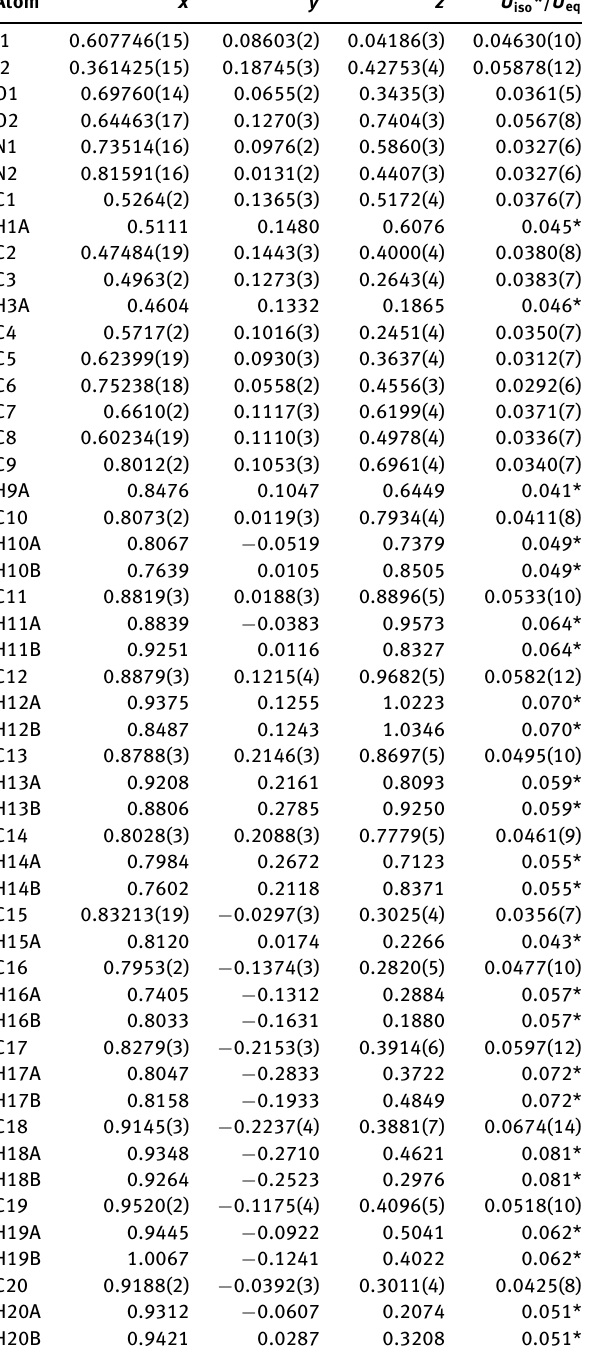
Table 2: Fractional atomic coordinates and isotropic or equivalent isotropic displacement parameters (Å 2